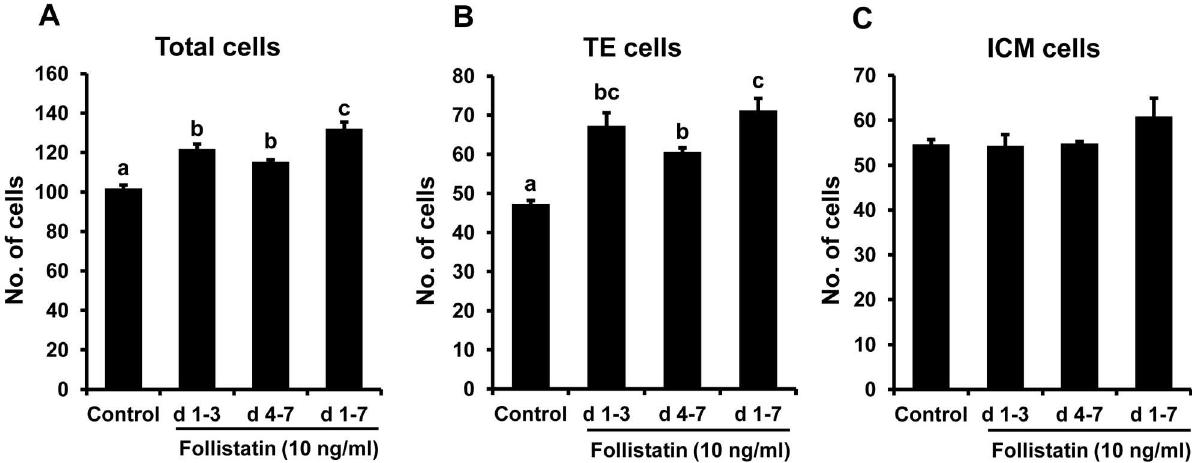
Fig 3. Stage-specific effectsof follistatin treatmenton bovine blastocyst cell allocation. Effect of exogenousfollistatinsupplementation duringpre-compaction(d 1–3),peri-/post-compaction(d 4–7)andentireperiod(d 1–7)of in vitro embryocultureon; (A) Total cell number. (B) Numberof TE cellsand (C) numberof ICM cellsas determined after differential stainingof resultingblastocyston d 7 after insemination. Valuesare shownas the mean ± SEM of the data collectedfrom 6 replicates(n = 25–30zygotes/treatment in eachreplicate). Values accompaniedwithdifferentlettersacrossthe treatmentsindicatesignificant difference(p < 0.05).